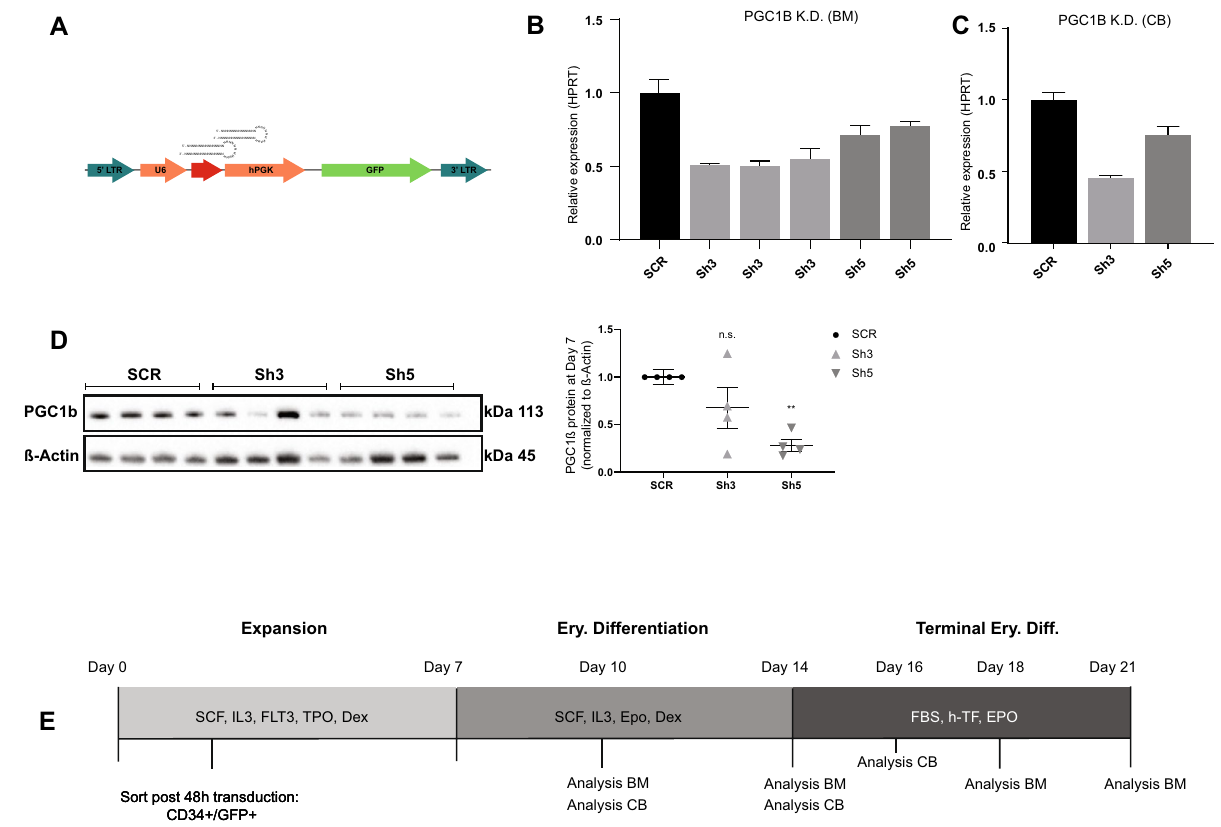
Sort post 48h transduction: CD34+/GFP+